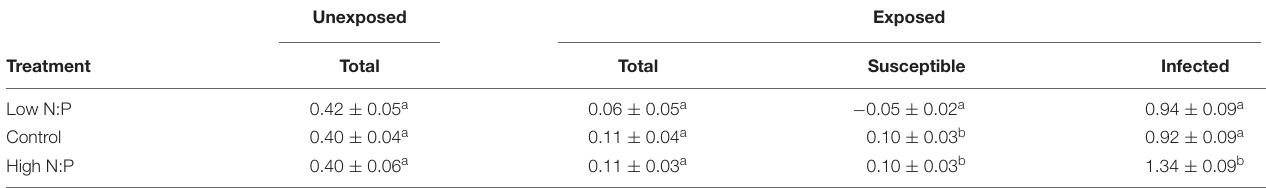
TABLE 1 | Planktothrix maximum net population growth rates (d − 1 ) of the different biomass fractions in the unexposed and chytrid exposed cultures. Unexposed Exposed